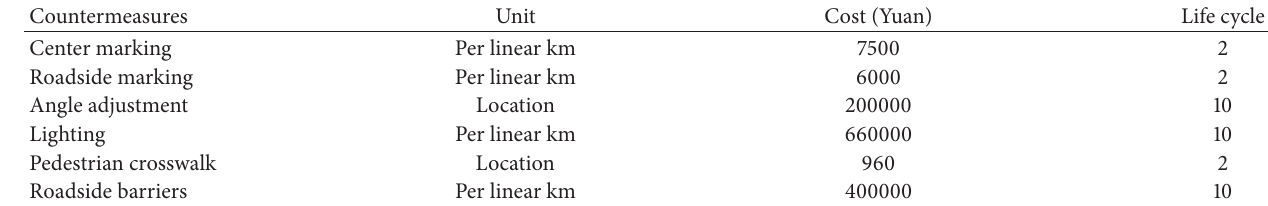
Table 7: Basic condition of countermeasures.